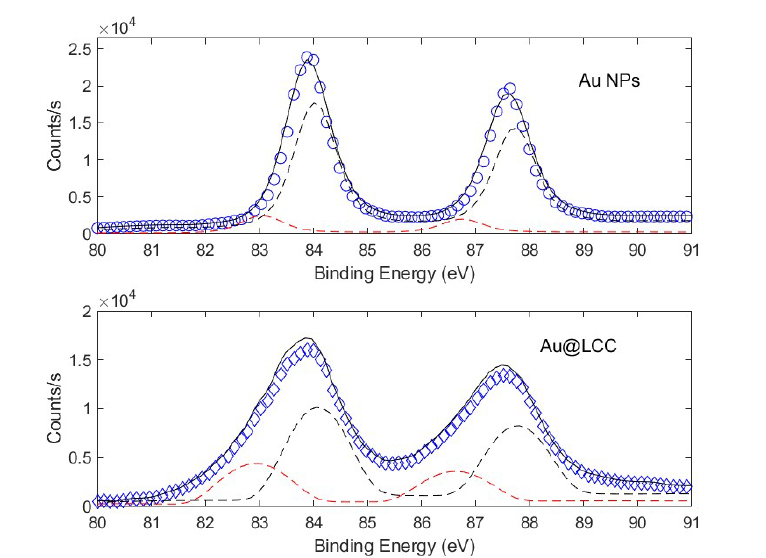
Figure 7. Au 4f lineshape deconvolution for NPs ( top ) and AuNPs@LCC ( bottom )